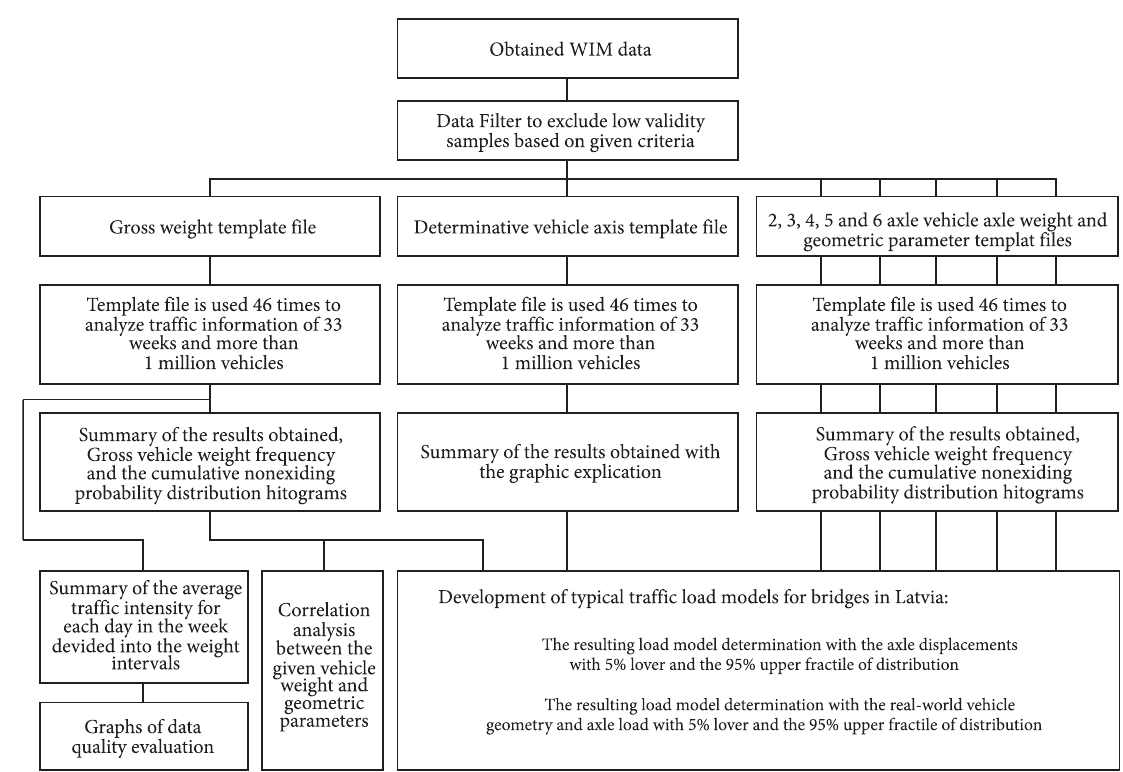
Fig. 1. Flowchart of the traffic load analysis